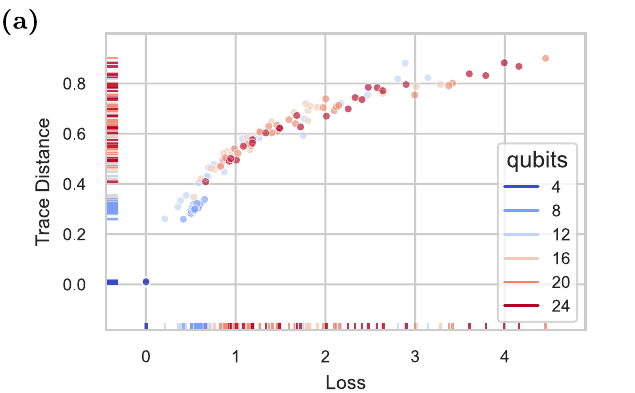
Fig.3|EmpiricalanalysisofVQE.a Scatterplotofthe fi nallossandtracedistance oftheVQEstateafter30,000stepsofgradientdescentoptimizationshowsthatthe algorithm converges to poorer local minima as the number of qubits grows. 24simulationsareperformedforeachvalueof n .Thealgorithmalwayssucceedsat obtaining the ground state with 4 qubits, but progressively struggles more with added qubits. b The number of layers needed to guarantee convergence to the